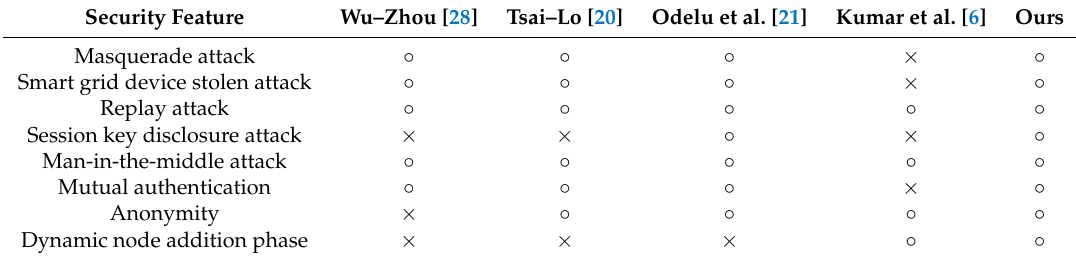
Table 2. A comparative summary: security features.